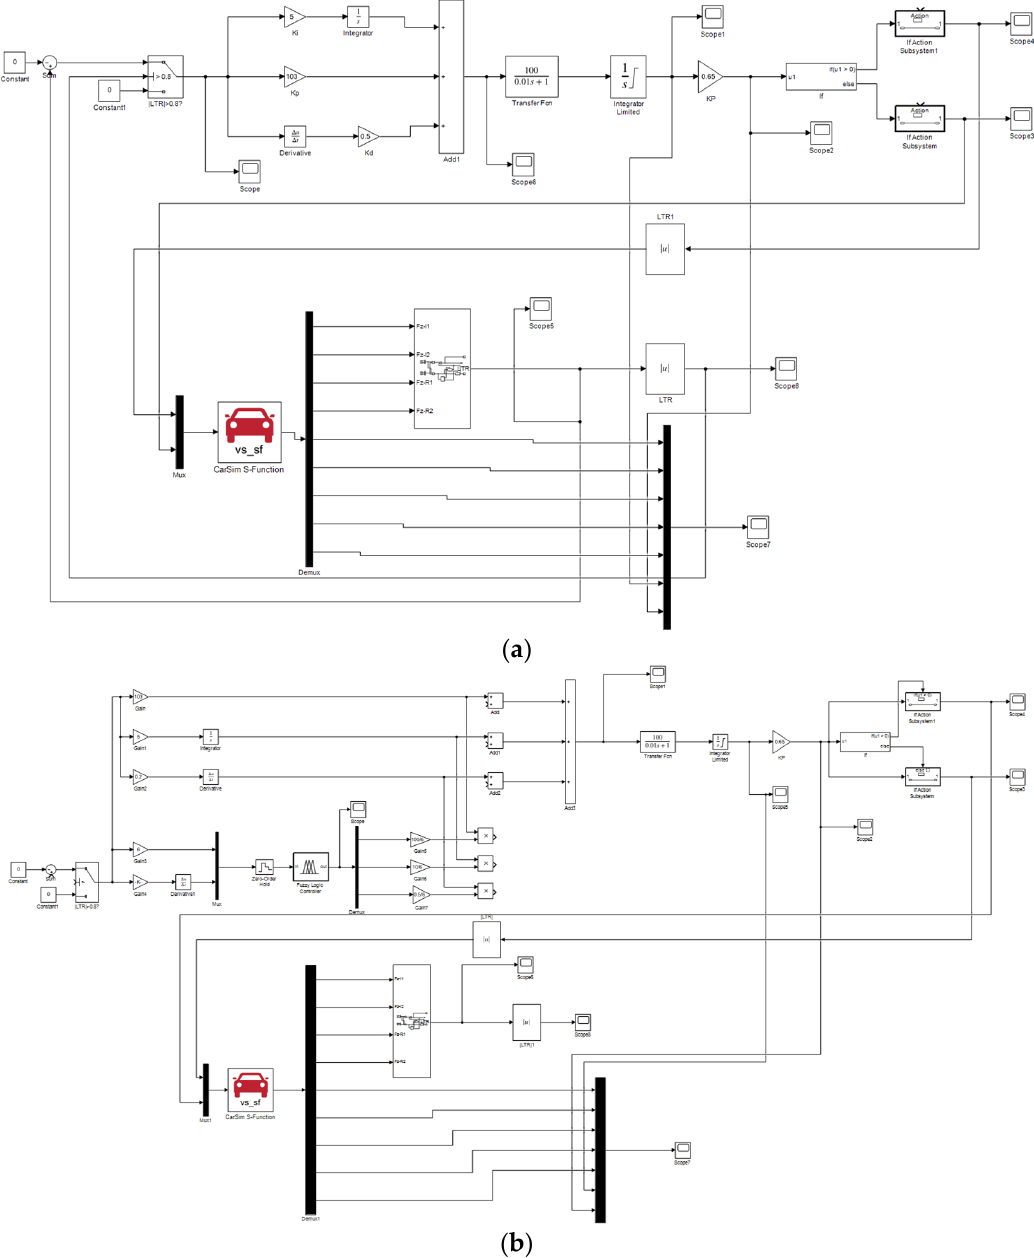
Figure 14. Co-simulation model. ( a ) PID whole vehicle control model; ( b ) Fuzzy PID whole vehicle control model.